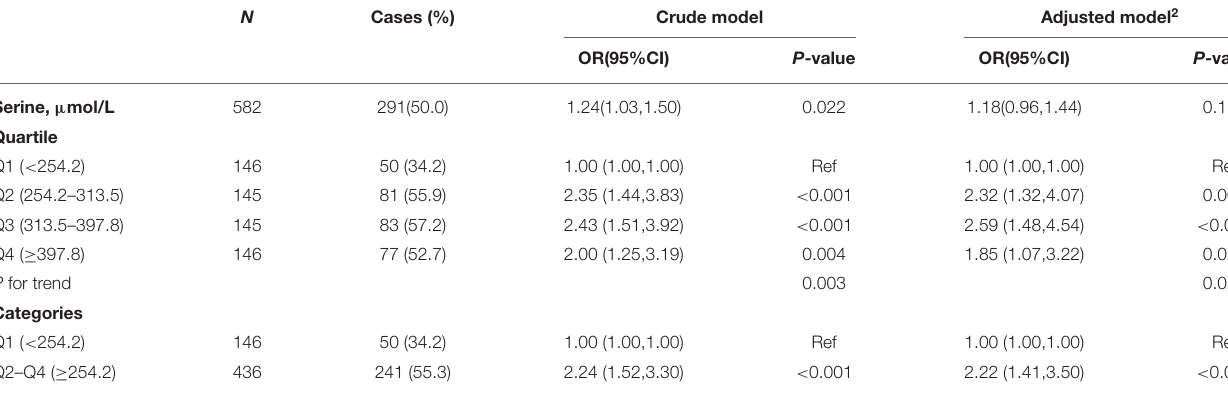
TABLE 2 | The risk of all-cause mortality with serum serine concentrations 1